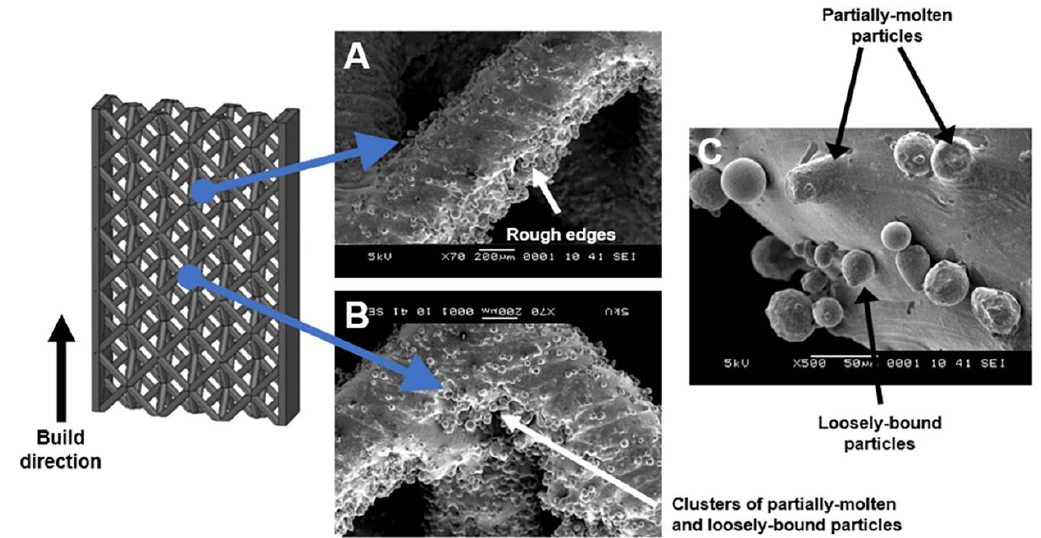
Figure 4. Scanning electron micrographs of the as-printed sample. ( A ) Rough edges on the under surface of the lattice. ( B ) Clusters of partially molten material at the joint. ( C ) Higher magnification image of the partially molten and loosely bound particles.